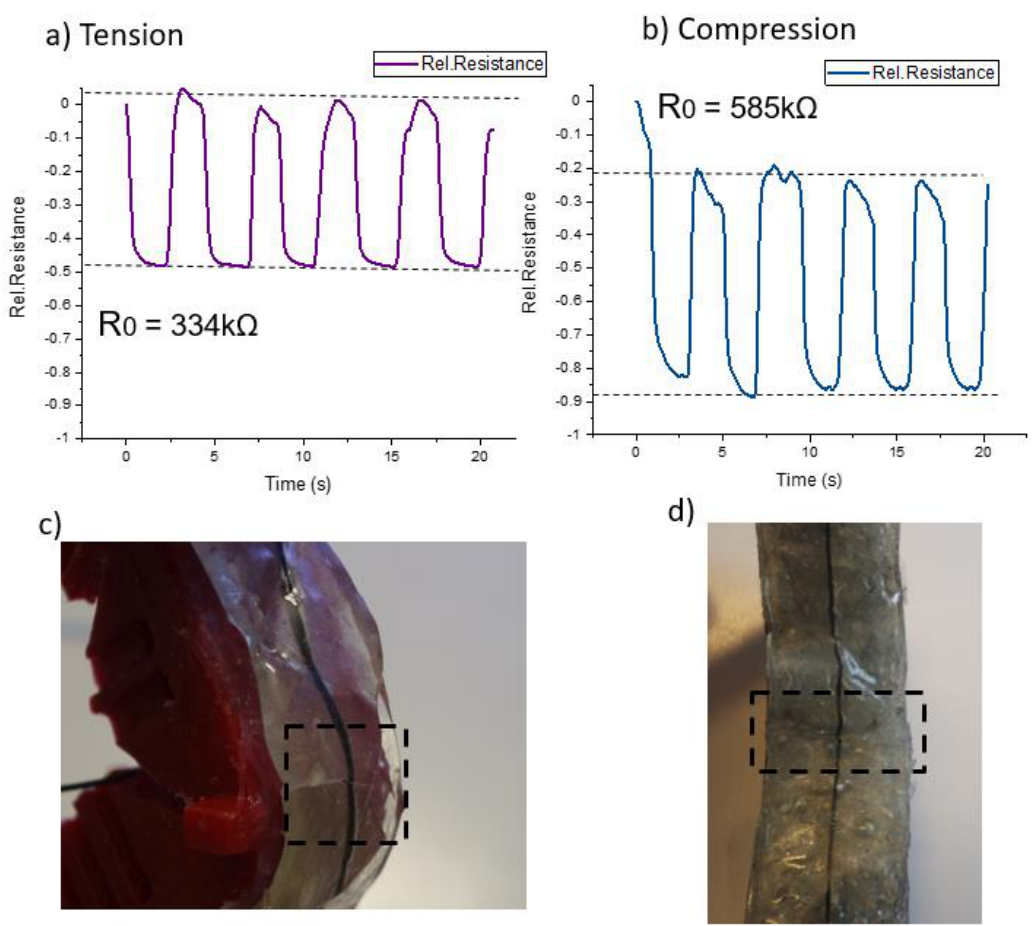
Figure 11. The electrical signal of the piezoresistive skin attached on ( a ) the tendon-based actuator and ( b ) the pneumatic- based actuator after healing the two cut parts of the composite in ( c ) the tendon-based actuator and ( d ) the pneumatic- based actuator.